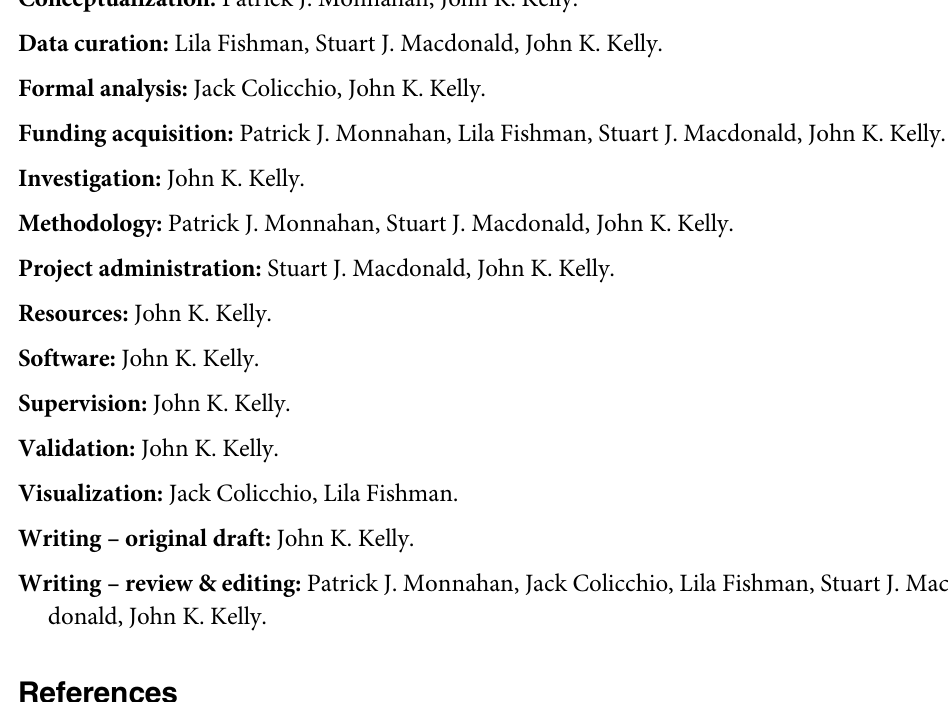
S9 Table. The best SNPs per gene evaluated by strength of evidence from two tests for selec- tion: (A) male selection ( p / p ) in 2013 versus male selection in 2014, (B) male selection in A M 2013 versus viability selection in 2014, and (C) male selection in 2014 versus viability in 2014. (XLSX) S1 Fig. The number of SNPs per read (Blue = Drosophila) or read-pair (Orange = Mimulus) is reported as a